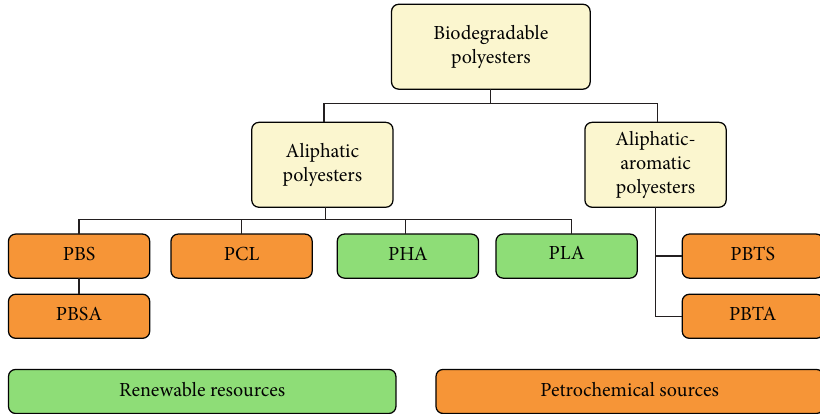
Figure 1: The division of (bio)degradable